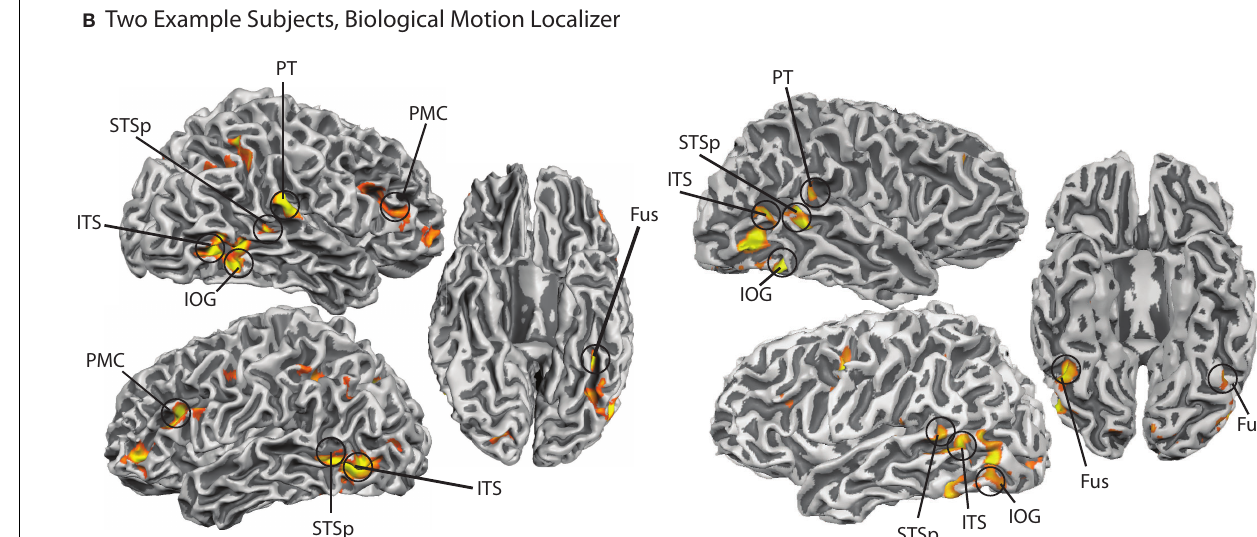
FIGURE 2 | Statistical maps and ROIs identifi ed with the biological motion localizer. (A) Biological motion selective regions as computed from a group average of all subjects (Experiments 1–4) on Talairach standardized data, shown on an individual subject’s anatomy. This analysis is shown only to demonstrate those regions that are consistently selective for biological motion, across our group of subjects. To account for individual differences in anatomical features (i.e., sulcal and gyral patterns), the primary experimental analyses for these experiments were computed in